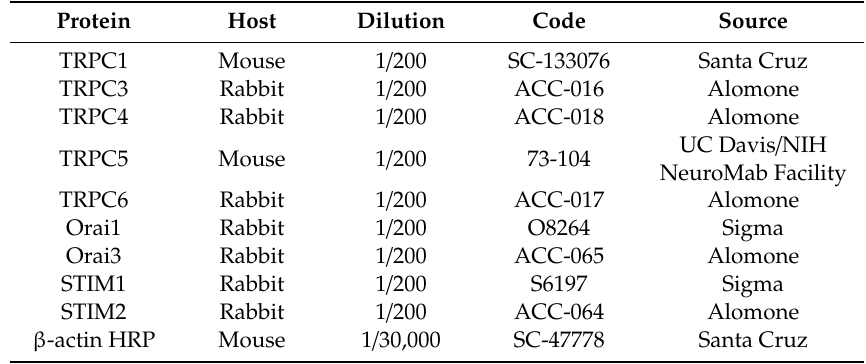
Table 1. List of primary antibodies. TRPC—transient receptor potential canonical channel.